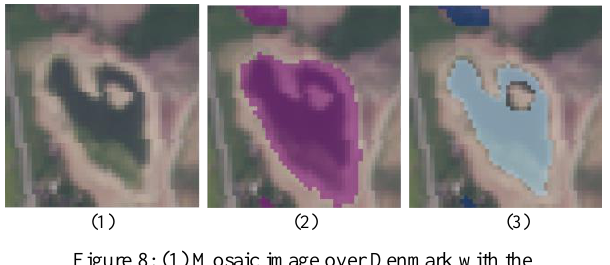
Table 2: Experimental assessment on the cities of Mailly and Nozay